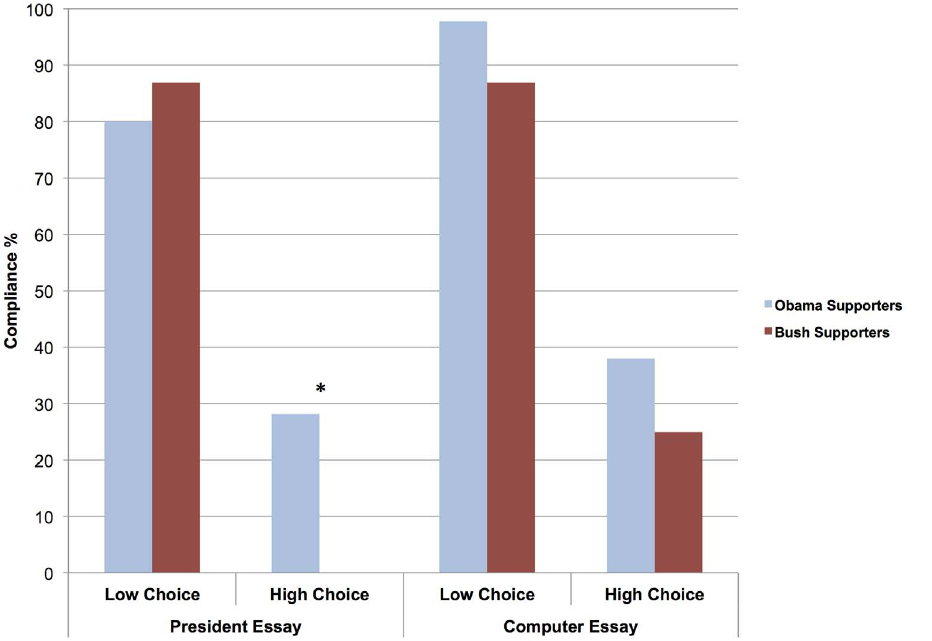
Figure 1. The percentage of Bush and Obama supporters in Experiment 1 who complied with instructions to write a counter- attitudinal essay in political and nonpolitical domains under conditions of low and high choice. Note: There were no compliers among Bush supporters under conditions of high choice with respect to the request to write a counter-attitudinal presidential essay. * p , .05, two-tailed.